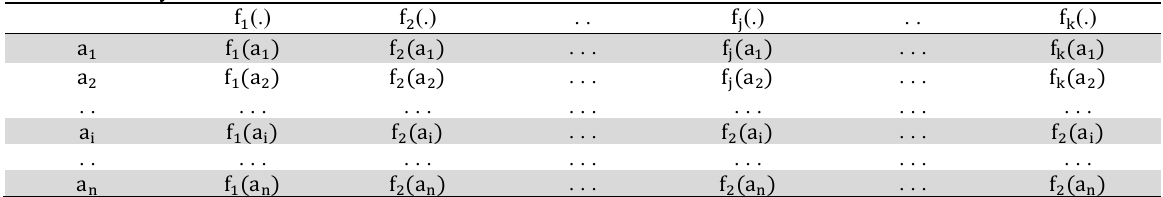
Basic Data Analysis of